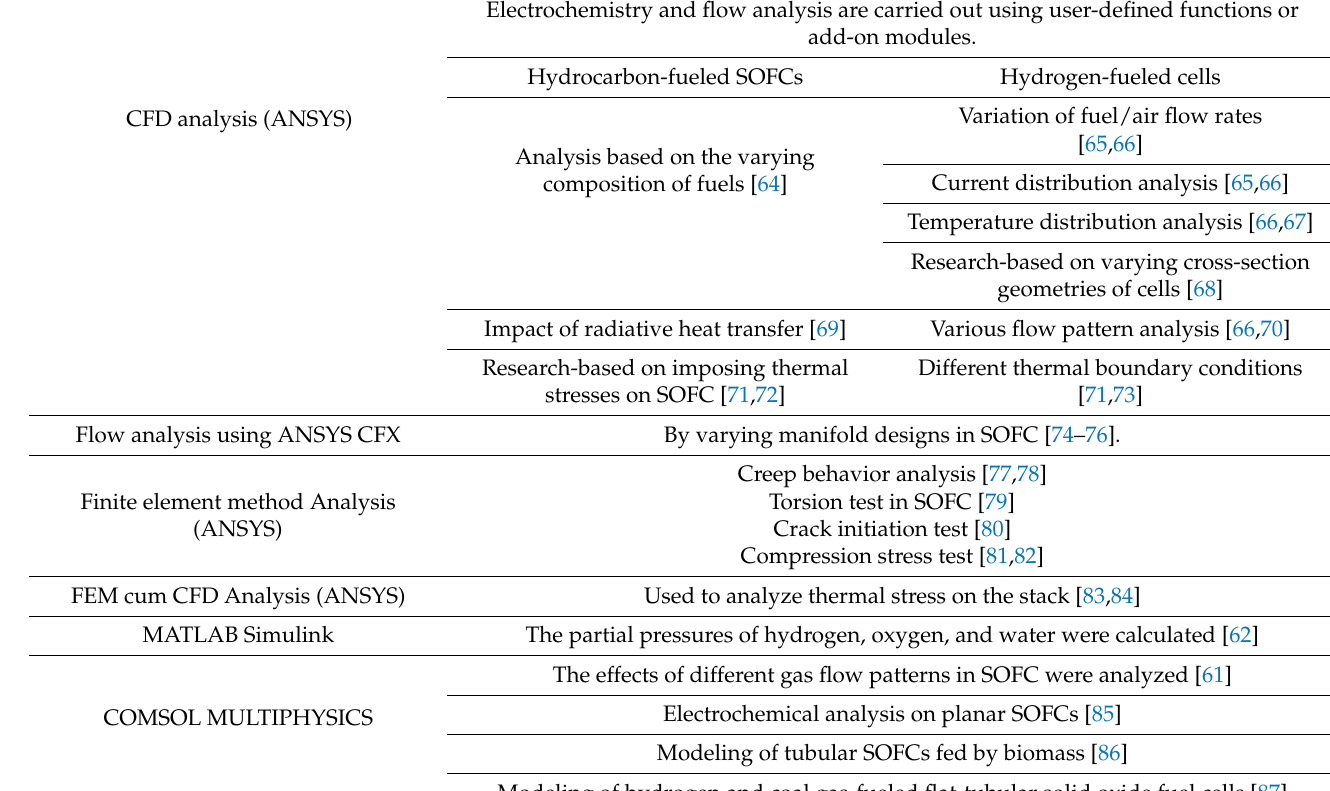
Table 3. Different types of modeling analysis are carried out in SOFCs using various commercial software